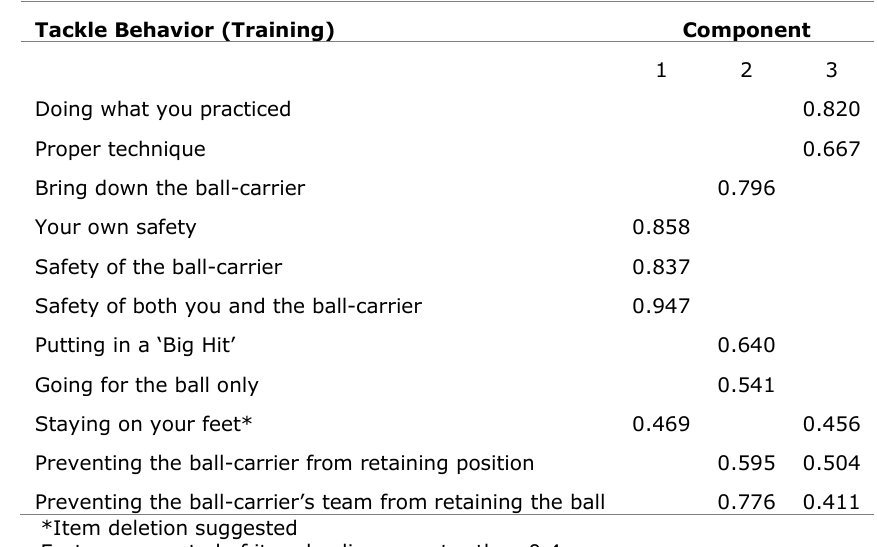
Table 7. Section 3 Rotated Component